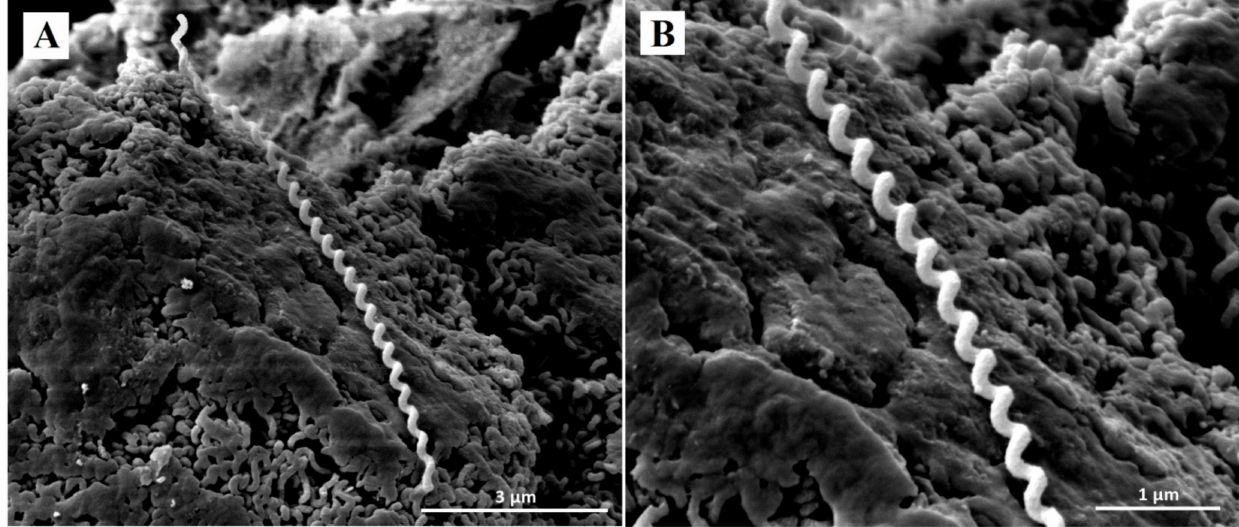
Figure 2. SEM micrographs of normal L. interrogans serovar Australis at 30,000 × ( A ) and 60,000 × ( B ) magnifications with perfect helical-shaped and hooked-end structures.